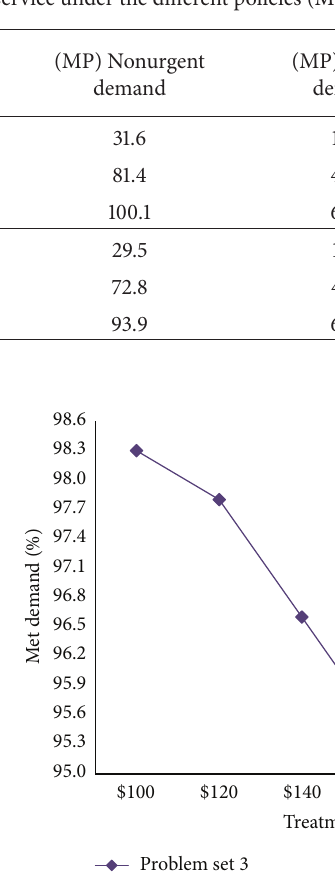
Figure 6: Met demand against treatment cost under MP policy, problem set